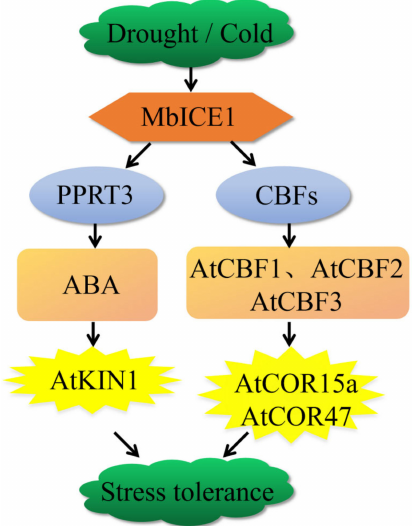
Figure 10. A model for drought or cold adaptation mediated by MbICE1 . MbICE1 receives the signals of drought and cold and directly combines with MYC elements in the CBF promoter to activate the expression of CBFs, thus positively regulating the expression of AtCOR15a and AtCOR47 and improving the survival ability of Arabidopsis under drought and cold stress. In addition, the accumulation of MbICE1 may regulate the ABA signal pathway by activating the RING type E3 ubiquitin ligase AtPPRT3 , thus increasing the expression of AtKIN1 and enhancing the plant’s adaptation to drought and